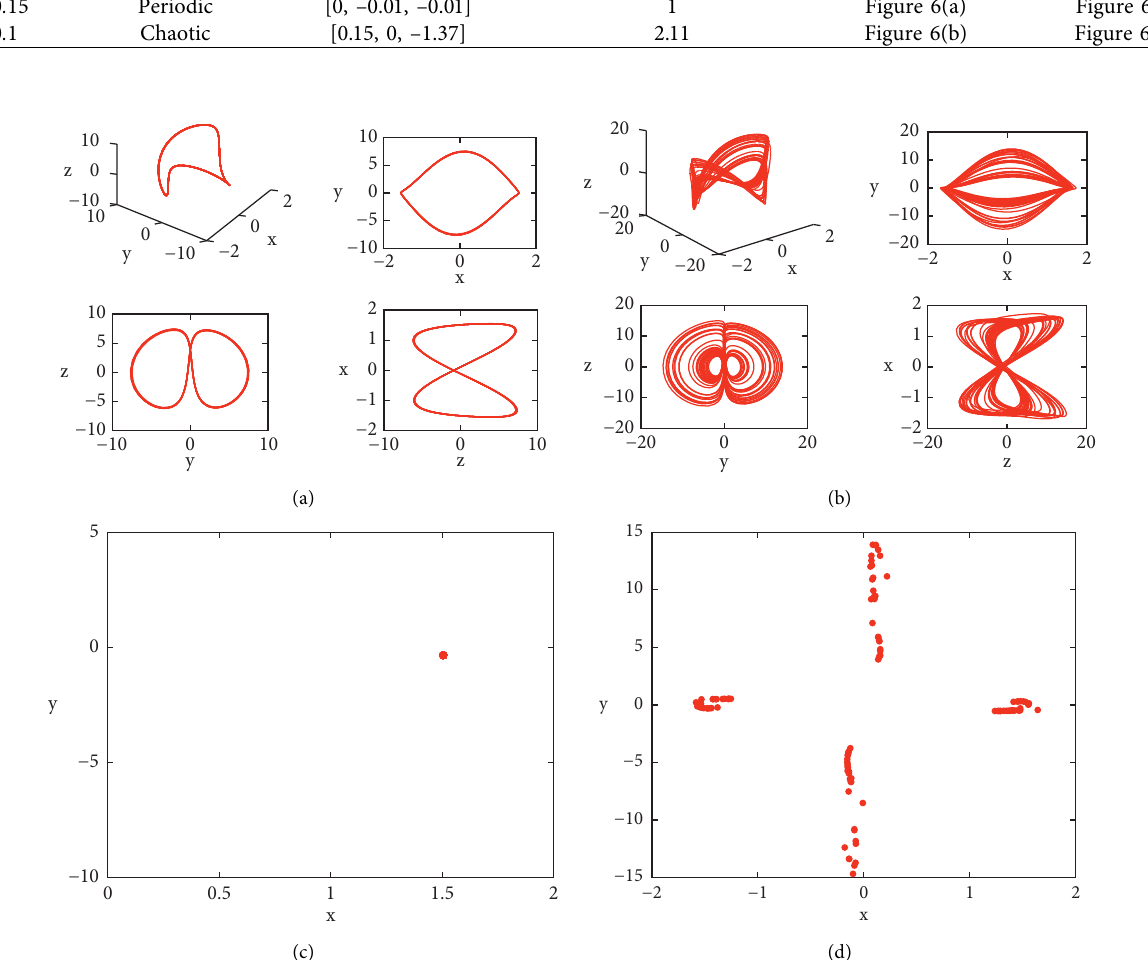
Table 4: Dynamics of system (1) for different parameter a with b � − 0 . 7 ,c � − 1 , and e � − 1 and initial values [ 0 , 0 . 9 , 0 ] . Parameter